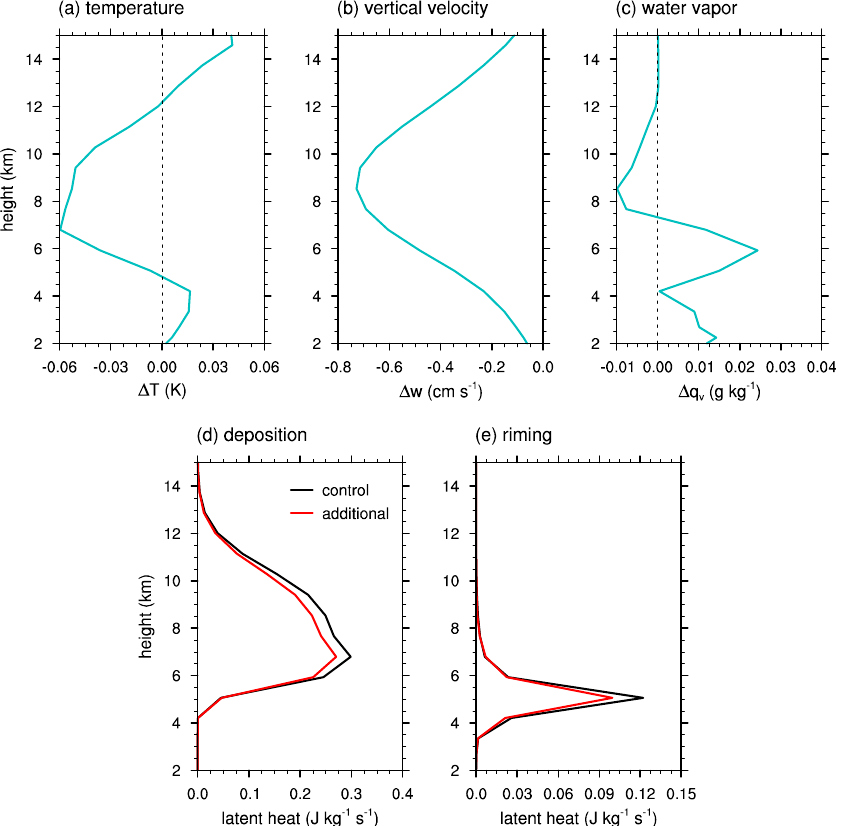
Figure 10. (Upper panels) Vertical profiles of deviations in horizontally averaged ( a ) temperature, ( b ) vertical velocity, and ( c ) water vapor mixing ratio obtained in the additional simulation from those in the control simulation. (Lower panels) Vertical profiles of horizontally averaged latent heat release by ( d ) deposition and ( e ) riming obtained in the control and the additional simulations. All the profiles are obtained by averaging from 03 LST to 13 LST.